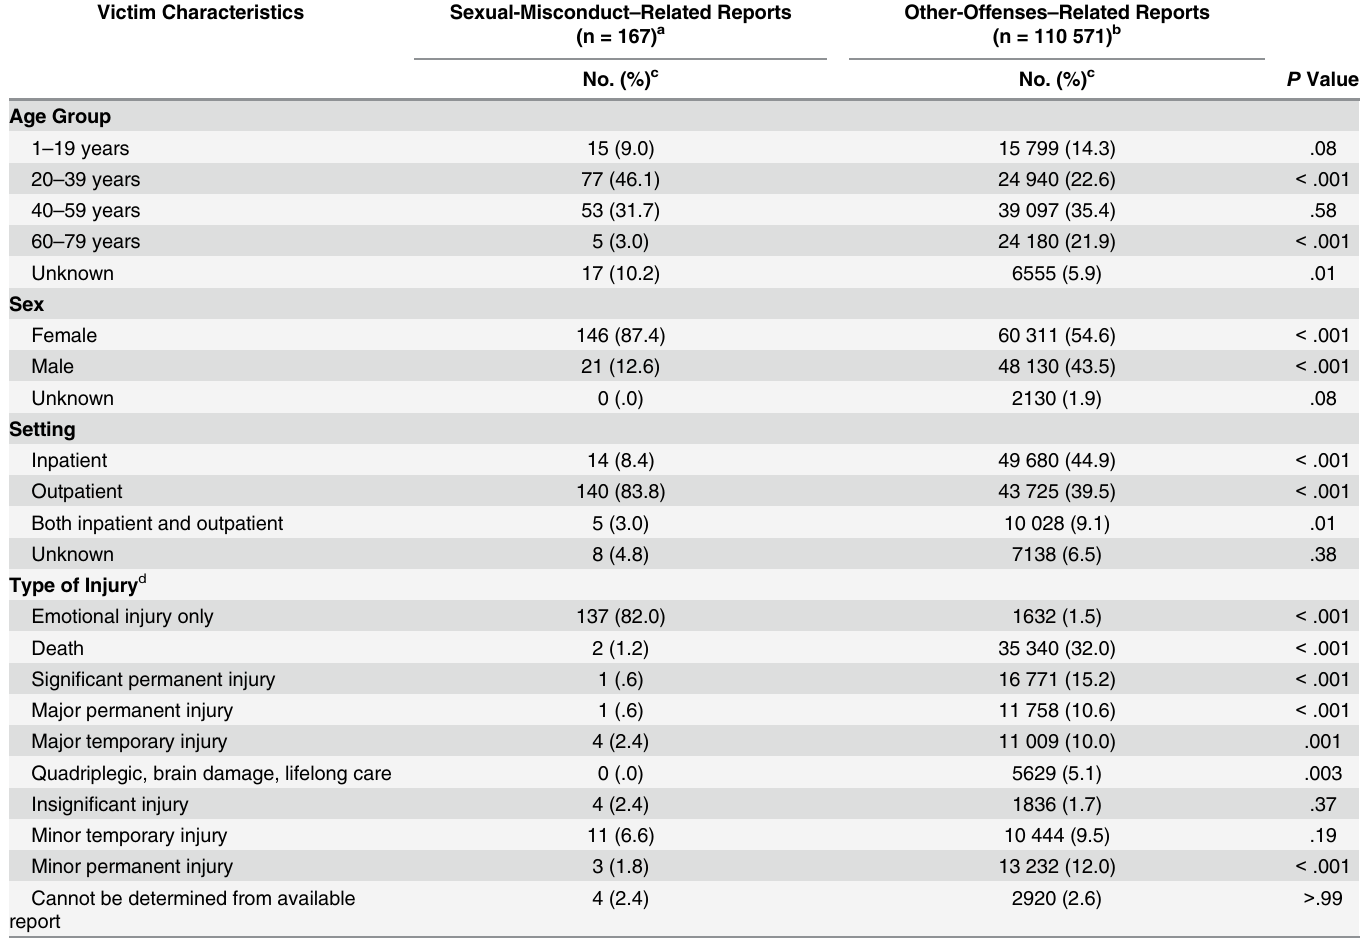
Table 3. Victim Characteristics and Type of Victim Injury in Physician Sexual-Misconduct – Related vs Physician Malpractice-Payment Reports Related to Other Offenses (Report-Level